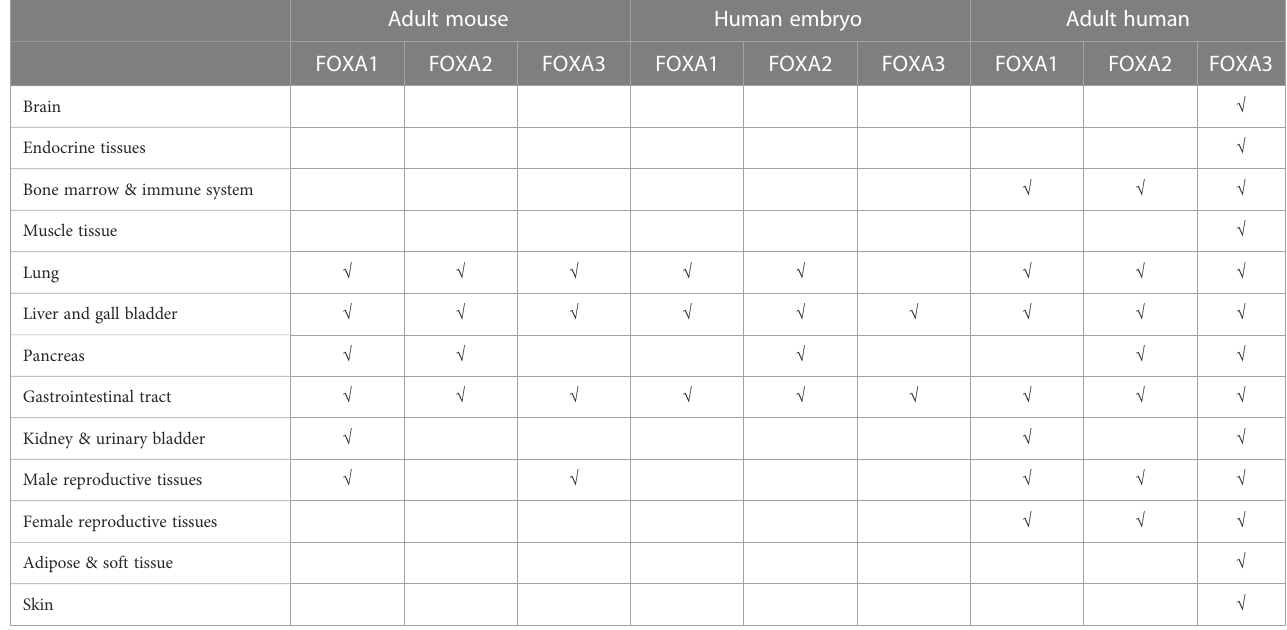
TABLE 1 The FOXA protein family express in multiple organs and tissues in humans and